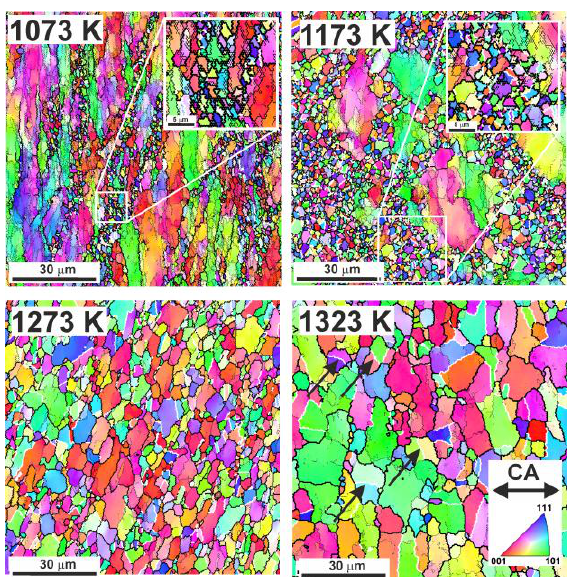
Figure 2. Typical microstructures that evolved in the high-nitrogen austenitic stainless steel during compression to a strain of 1.2 at 1073–1323 K and a strain rate of 10 −3 s −1 . The thin and thick lines correspond to the subgrain and grain boundaries, respectively. The white line corresponds to CSL Σ3 n boundaries. The colors reflect the inverse pole figures for the compression axis (CA). The arrows indicate some typical twins by growth accident.